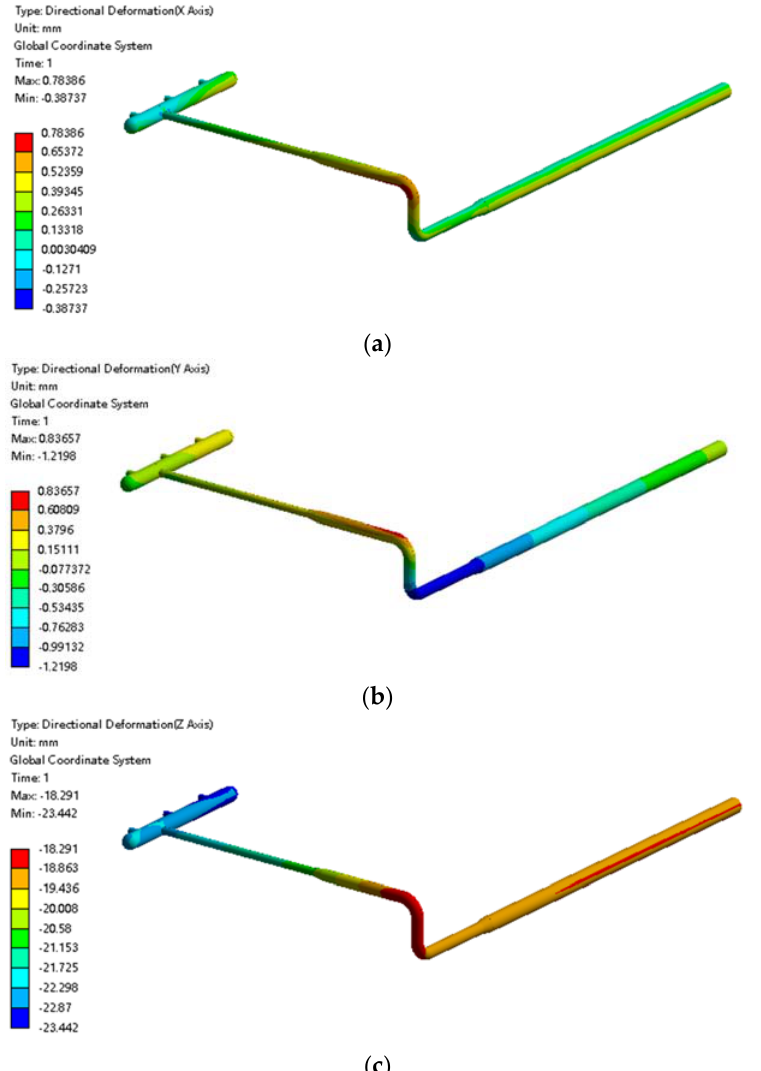
Figure 21. Cloud diagram of pipeline displacement at − 1 °C: ( a ) cloud diagram of pipeline displace- ment at the x direction; ( b ) cloud diagram of pipeline displacement at the y direction; ( c ) cloud diagram of pipeline displacement at the z direction.